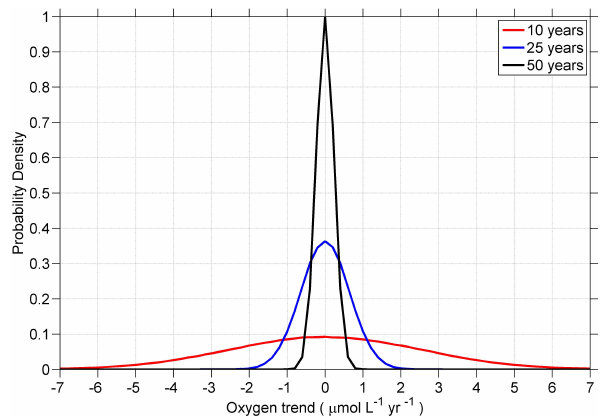
Fig. 9. Probability density diagram of oxygen concentration trends obtained from one million synthetic oxygen time series with length equal to 10 years (red), 25 years (blue) and 50 years (black), as- suming random white noise with an interannual standard deviation of 23µmolL − 1 , the median standard deviation of the oxygen time series listed in Table